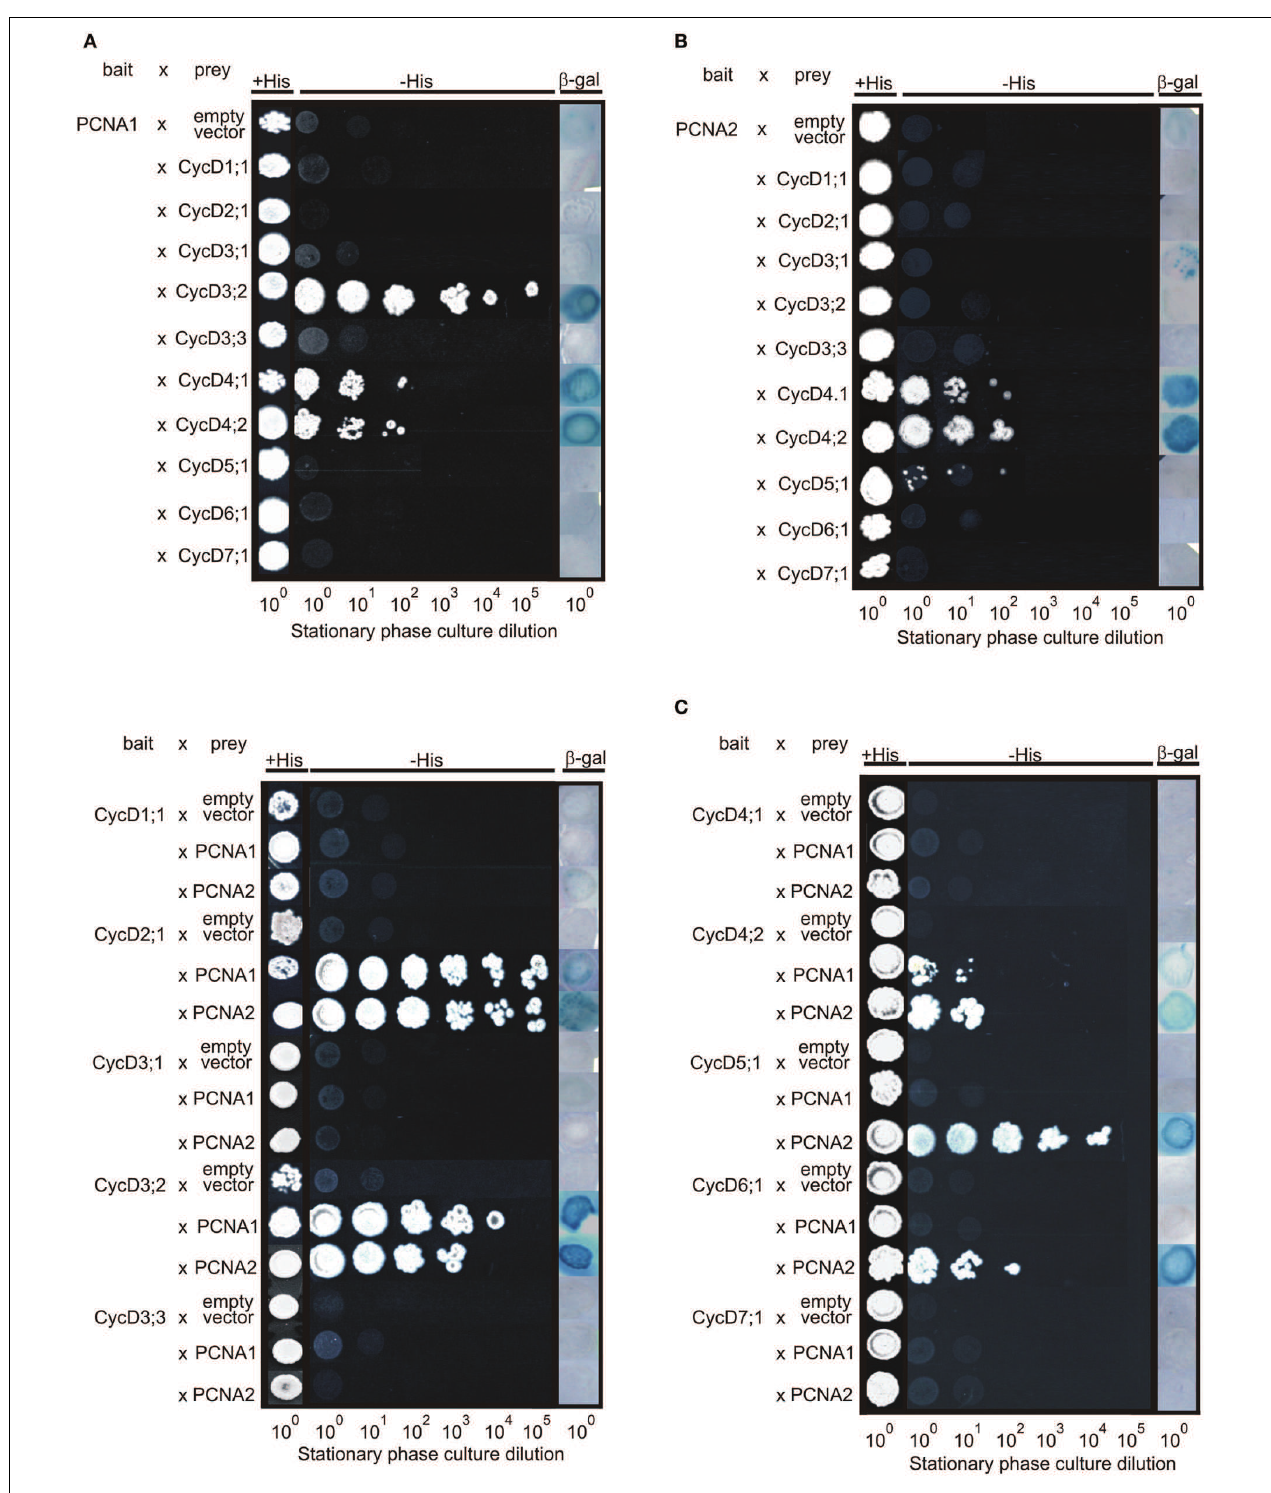
SC-Leu-Trp-His selection solid medium supplemented with 10mM 3-aminotriazol (3-AT). For the beta-galactosidase assay, the yeast transformants were grown on a nitrocellulose filter placed on the surface of a YPAD solid medium followed by incubation with X-gal. The results are representative of three independently repeated